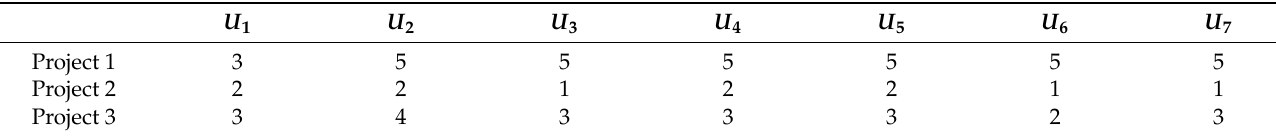
Table 18. Scoring table of data required by the